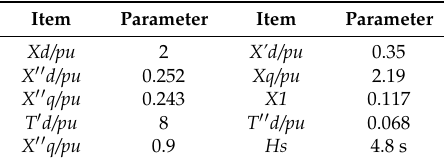
Table A2. Parameters of synchronous generator SG.